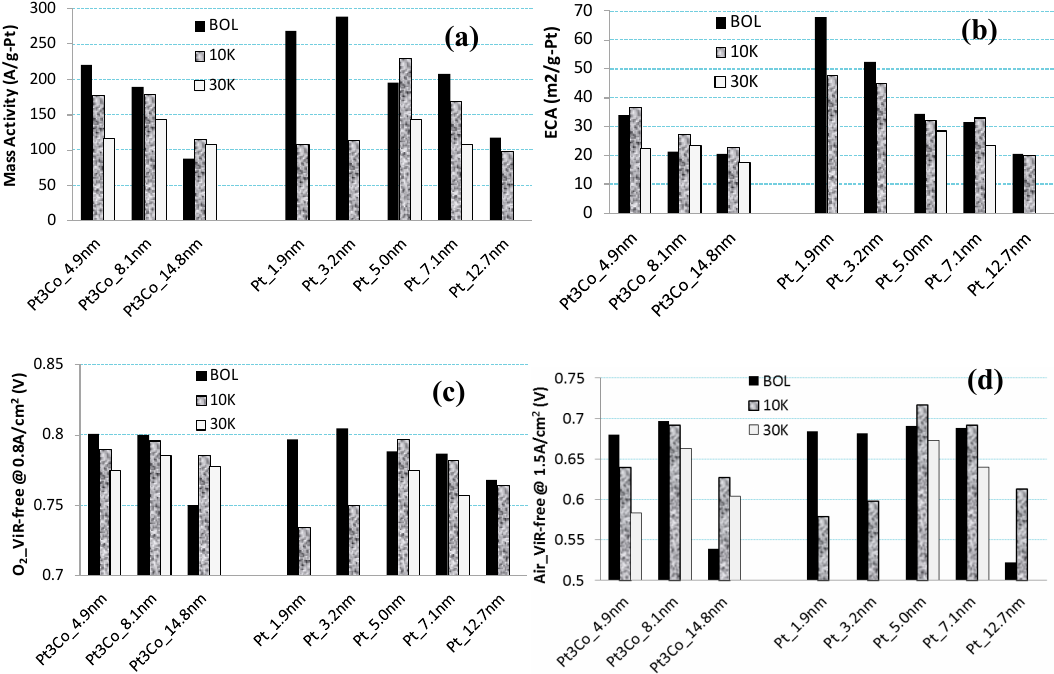
Figure 7. Comparison of Pt vs. Pt 3 Co decay trends as a function of potential cycles. ( a ) Mass Activity, ( b ) ECA, ( c ) H 2 /O 2 performance at 0.8 A/cm 2 , ( d ) H 2 /Air performance at 1.5 A/cm 2